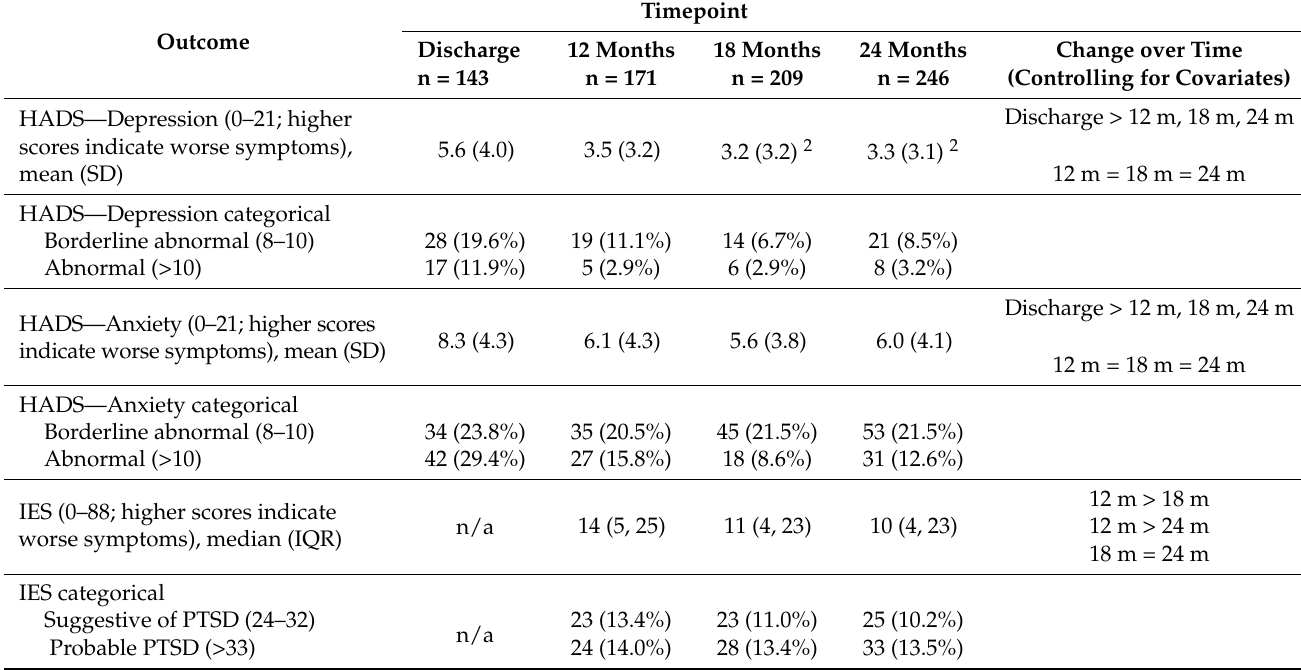
Table 2. Well-being over time for 303 parents of neonates with acute symptomatic